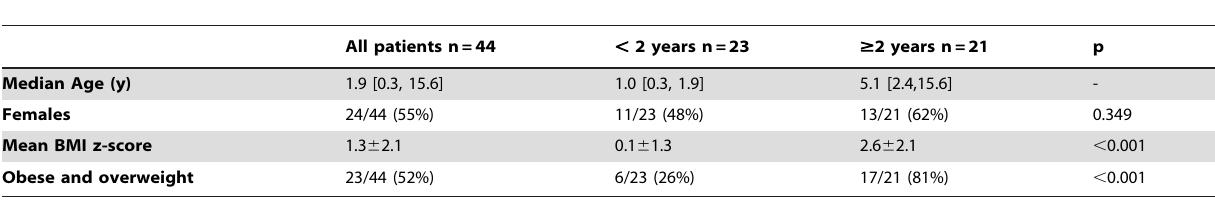
Table 1. Demographic and Anthropometric Data in Children with